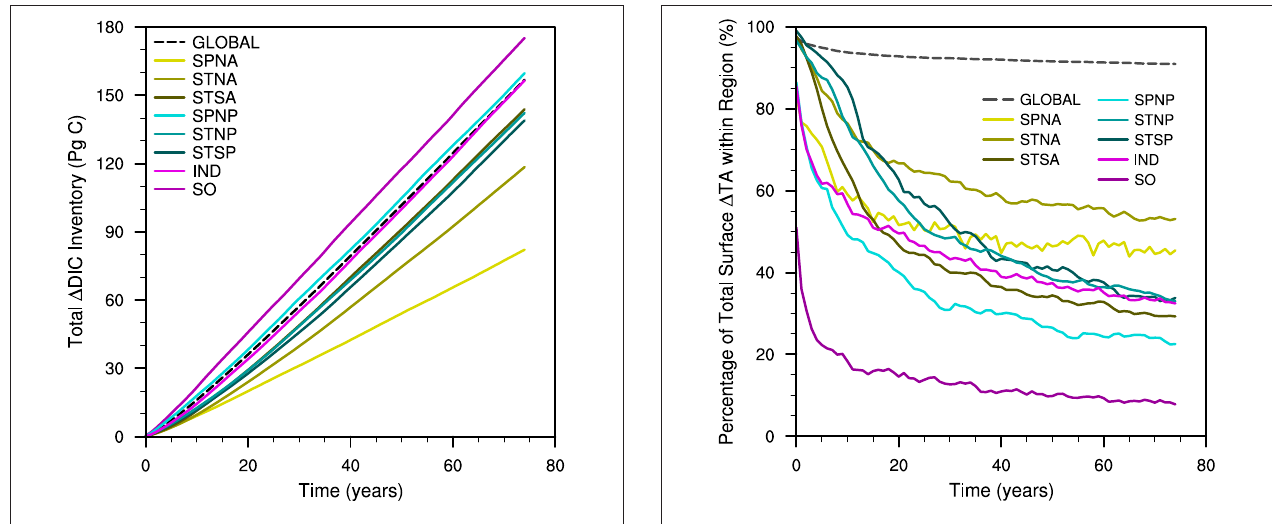
FIGURE 4 | Time series of total dissolved inorganic carbon inventory anomaly against time for the global (dashed) and different regional (solid) ocean alkalinity enhancement experiments.